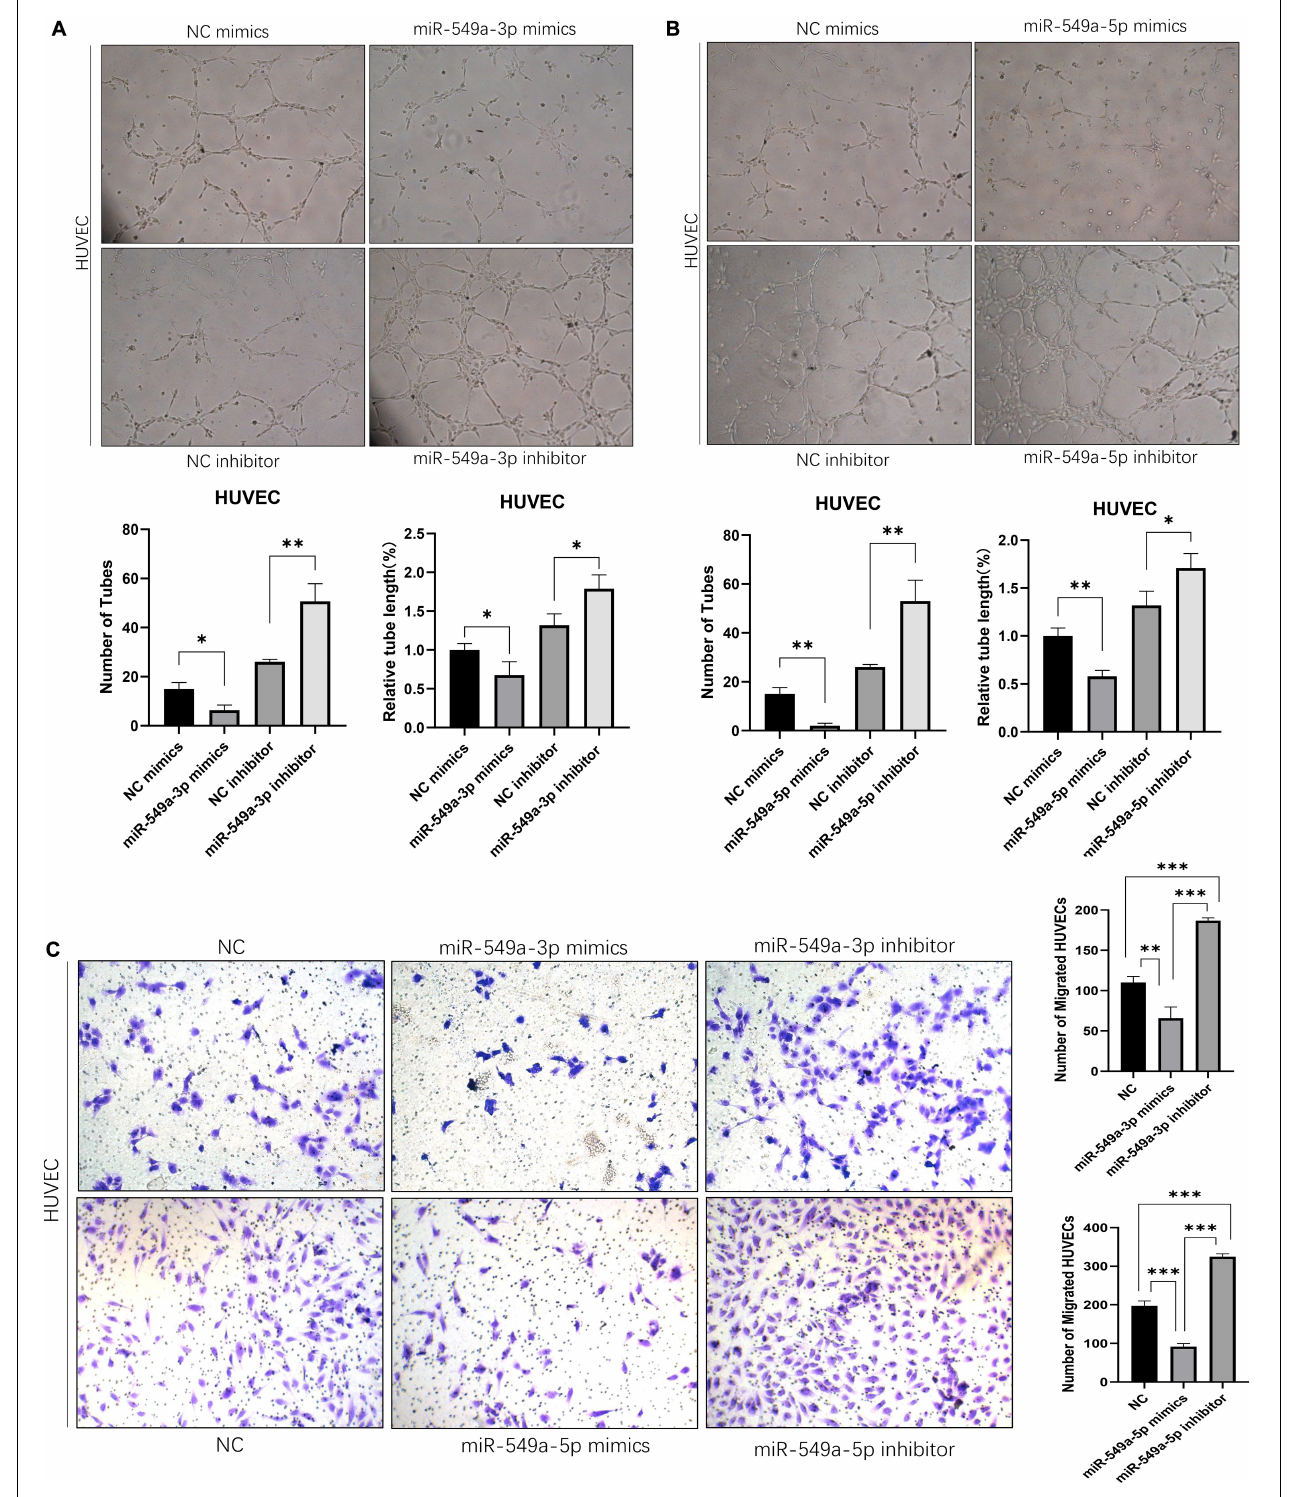
FIGURE 4 | Exosomal miR-549a affects angiogenesis and endothelial cell migration. (A,B) Effect of miR-549a-3p mimics/inhibitor (A) , miR-549a-5p mimics/inhibitor (B) on tube formation ability of HUVECs by tube formation assay. Mean ± SEM are provided ( n = 3). (C) Effect of miR-549a-3p/miR-549a-5p mimics and inhibitor treatment on migration of HUVECs. Mean ± SEM are provided ( n = 3). ∗ P < 0.05, ∗∗ P < 0.01, ∗∗∗ P < 0.001 according to two-tailed Student’s t -test.